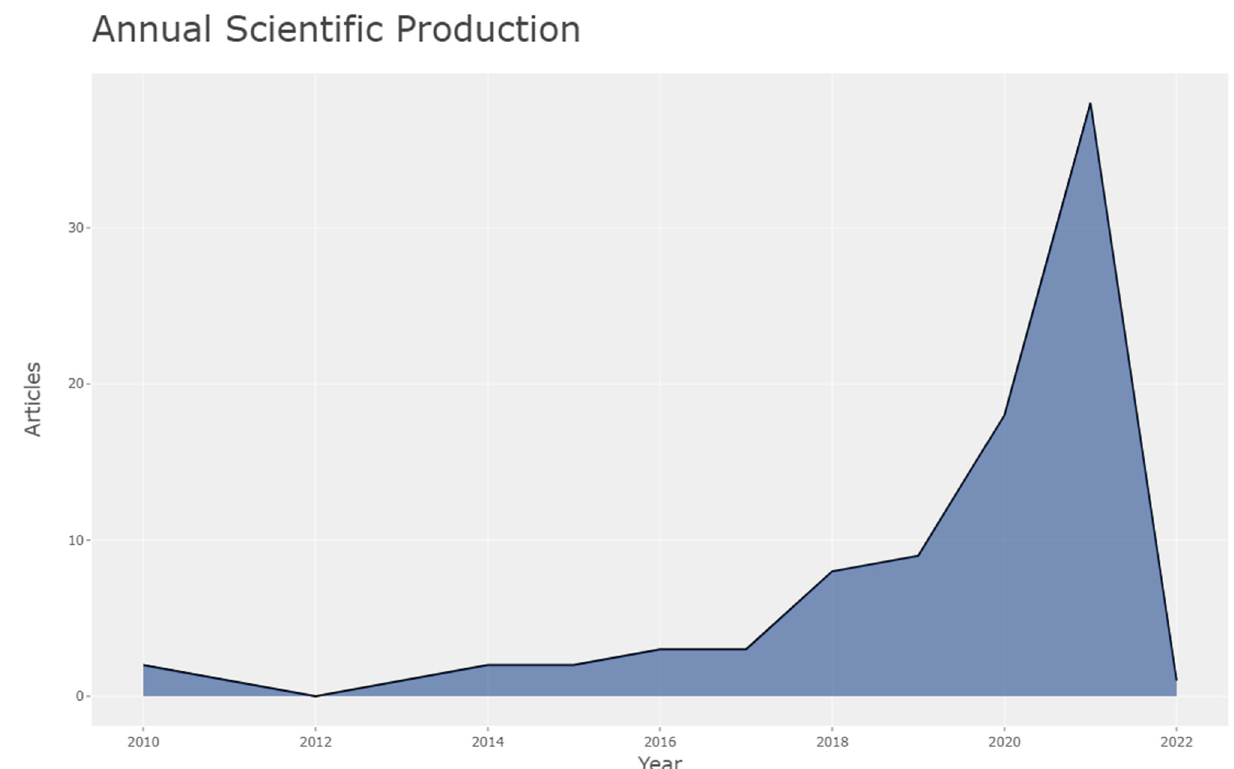
Figure 2. Annual Scientific Production.